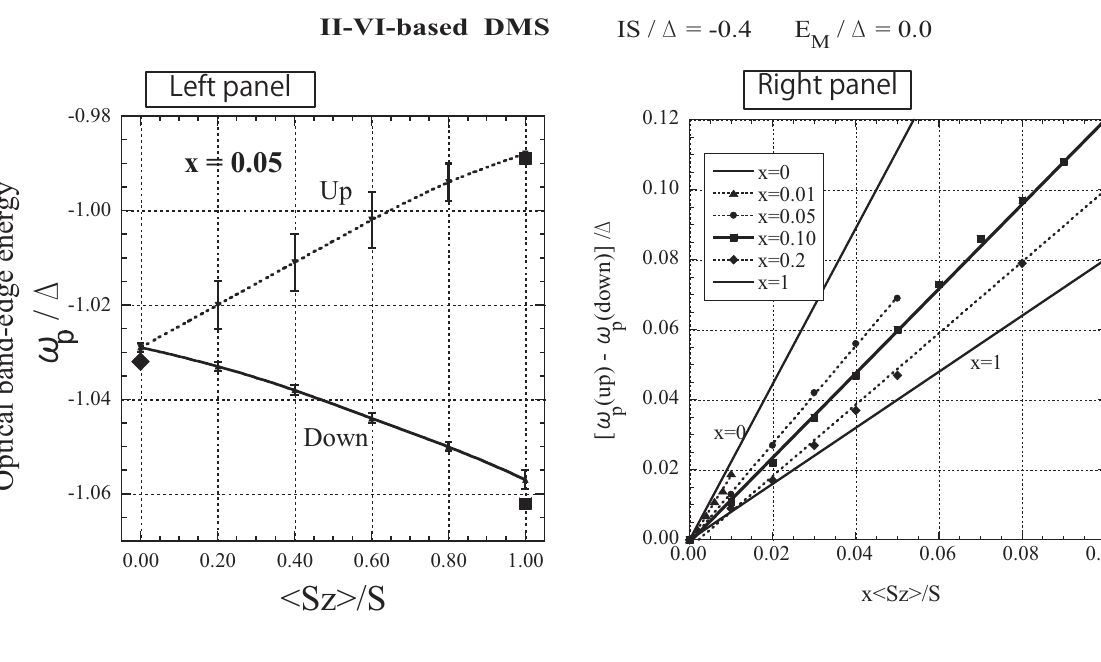
Figure 7. Left panel: Absorption peak energy ! The solid line represents the down-spin carrier and the dotted line represents the up-spin carrier. The error bar represents the half-peak width. The values of ! obtained by a simple approximation are plotted as dots on the lines of ⟨ S ⟩ = 0 (see text). Right panel: Exchange splitting [ ! and ⟨ S z ⟩ =S for various values of x . The straight lines are adjusted as a function of x ⟨ S z to obtain the best fit with each set of x data. From Takahashi